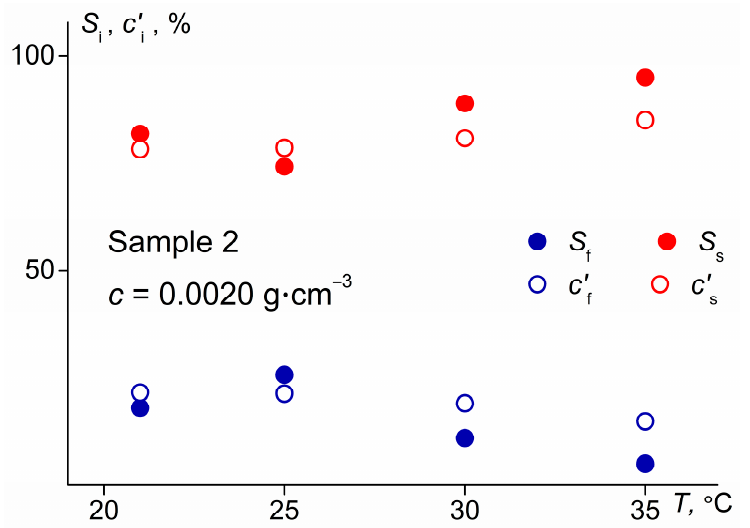
Figure 9. The dependences of S * f , S * s , c ’ f and c ’ s on temperature for aqueous solution of Sample 2 with concentration c = 0.0020 g·cm − 3 .